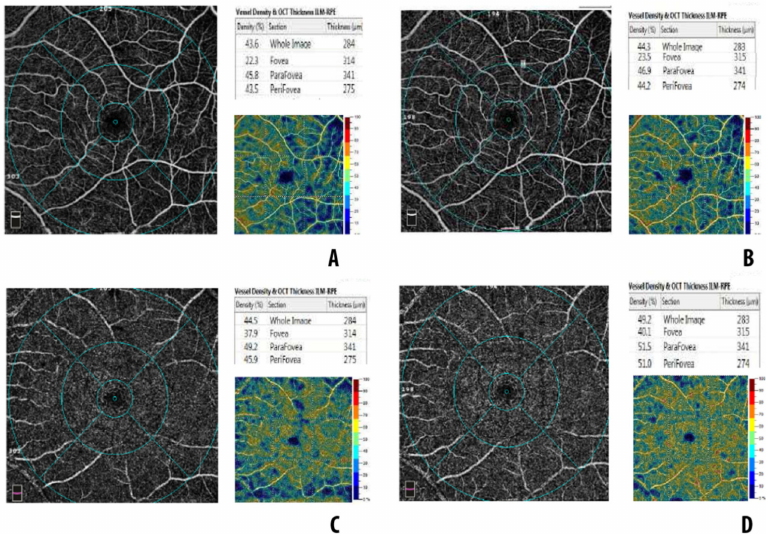
Figure 3. OCTA imaging in a case of macula-off retinal detachment: ( A ) superficial capillary plexus at 1 month postoperatively; ( B ) superficial capillary plexus at 6 months postoperatively; ( C ) deep capillary plexus at 1 month postoperatively; ( D ) deep capillary plexus at 6 months